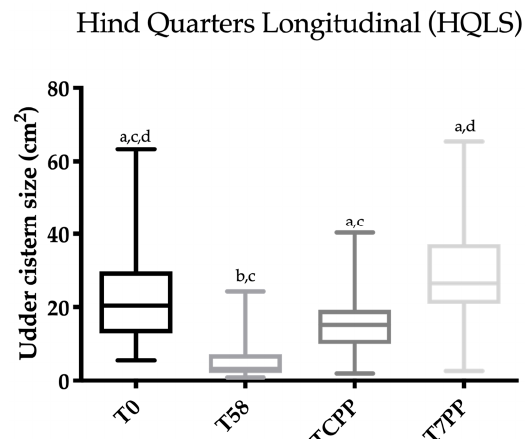
Figure 6. Scatter box plot showing the median, minimum and maximum values of the ultrasonographic udder cistern size between T0 vs. T58 vs. T colostrum production phase (TCPP) vs. T 7 days post-partum (T7PP) for the hind quarter longitudinal section (HQLS). Legend: a ≠ b ≠ c ≠ d: p < 0.05.